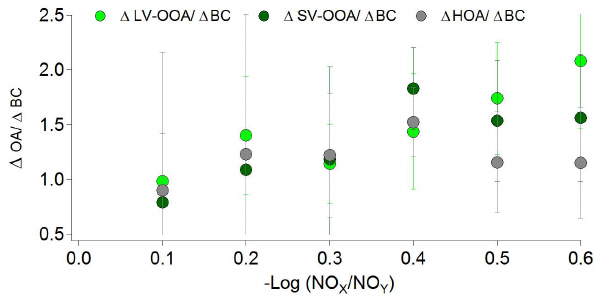
Fig. 6. The ratio ( ± 1 σ) of 1 LV-OOA/ 1 BC, 1 SV-OOA/ 1 BC, and 1 HOA/ 1 BC as a function of photochemical age ( − log(NO x /NO y )